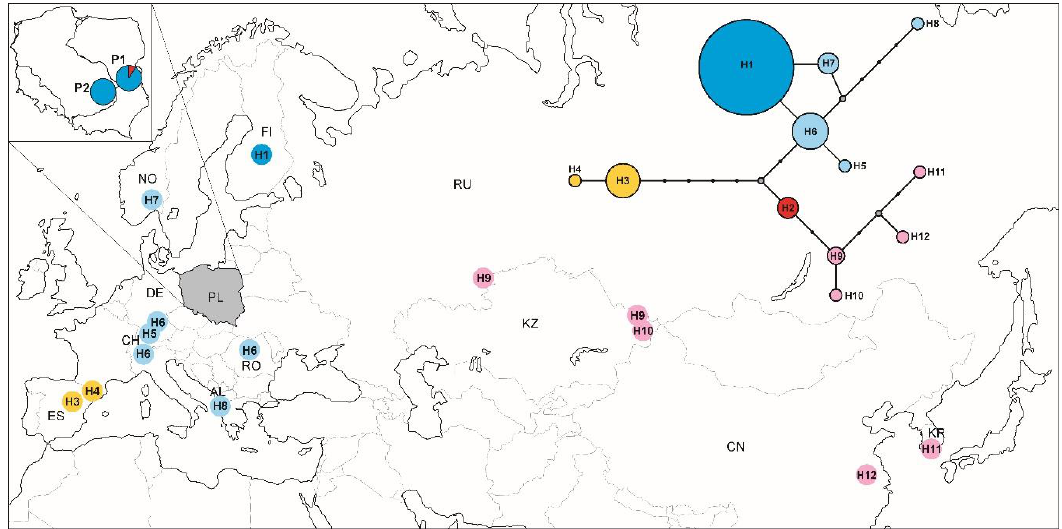
Figure 2. Distribution of COI haplotypes among populations of Scolitantides orion in Poland (PL) and different localities within its range (sequences available in the GenBank database). Haplotype network reconstruction was drawn using the median-joining method. The sizes of the circles on the haplotype network are directly proportional to the number of individuals analysed.